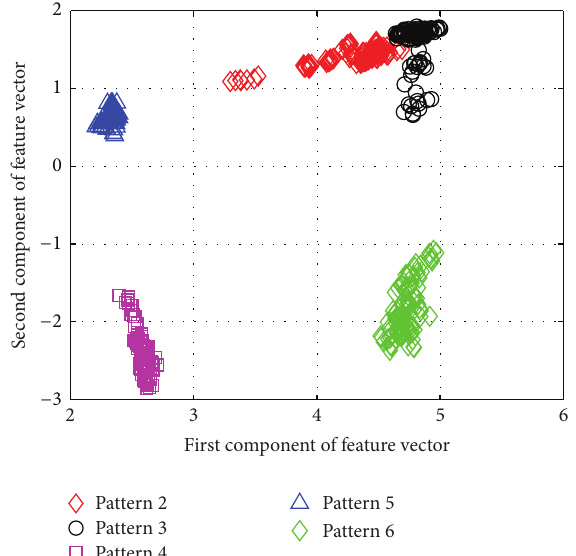
Figure 6: The AR feature vectors of data patterns in first scenario from sensor node 232 using Mahalanobis distance.